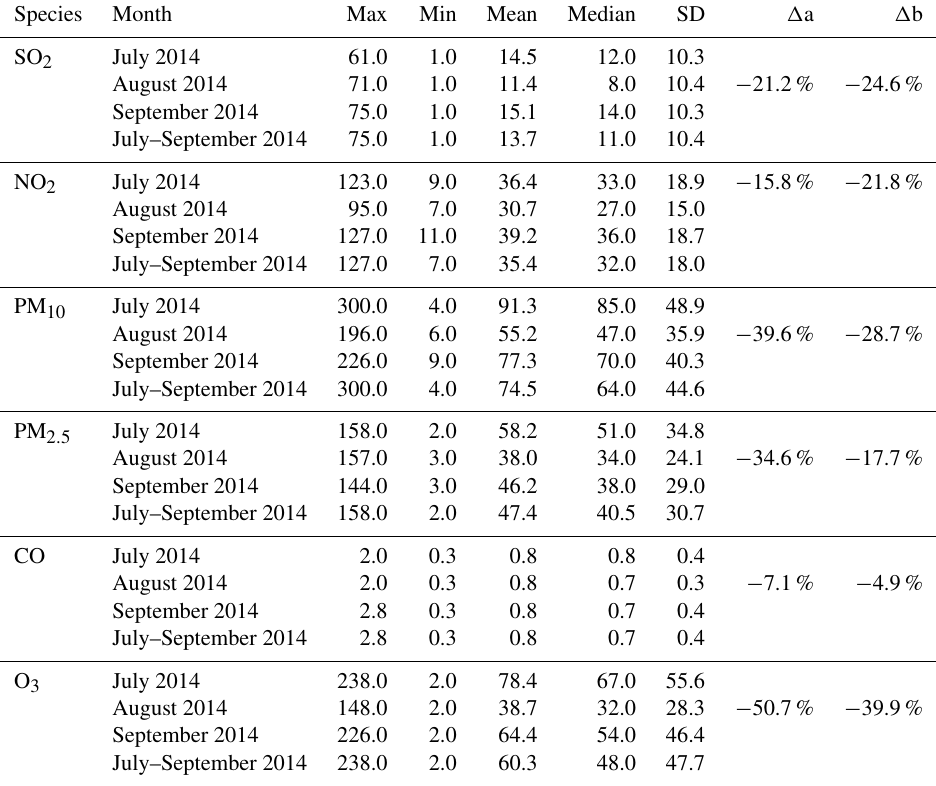
Table 5. Statistical analysis of hourly data in July–September 2014 at XL station (the unit is µgm − 3 except CO (mgm − 3 ) ). The change percentage of species ( (cid:49) a) in August 2014 based on July 2014. The change percentage of species ( (cid:49) b) in August 2014 is based on September